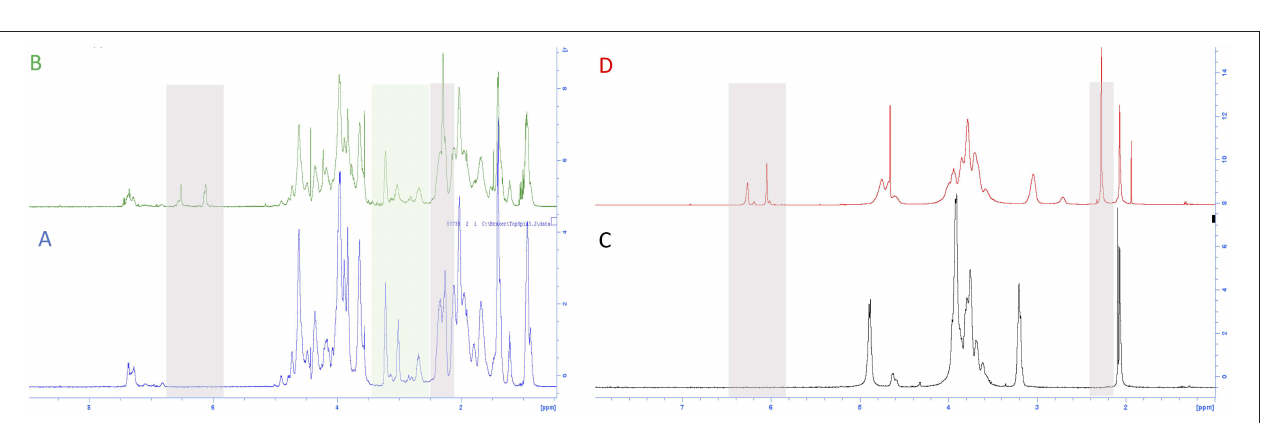
FIGURE 2 | FT-IR spectra of (A) functionalized and unfunctionalized GE (B) functionalized and unfunctionalized CH.